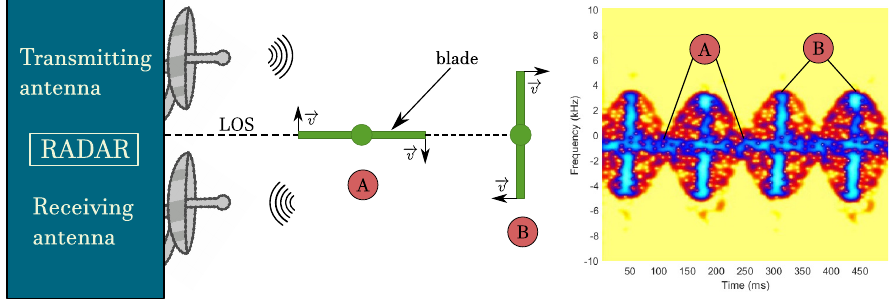
Figure 11. Micro-Doppler modulation of drone